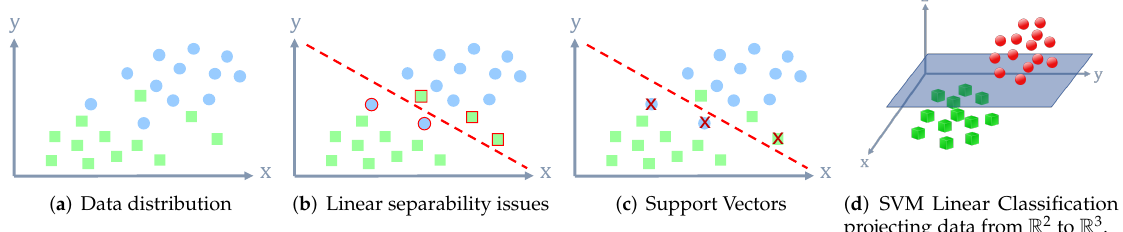
Figure 2. SVM linear classification. The final result presented in ( d ) illustrates how the circle data group is above the plane formed by the SVM. On the other side, the square data group is below the plane. ( a ) Data distribution; ( b ) Linear separability issues; ( c ) Support Vectors; ( d ) SVM Linear Classification projecting data from R 2 to R 3